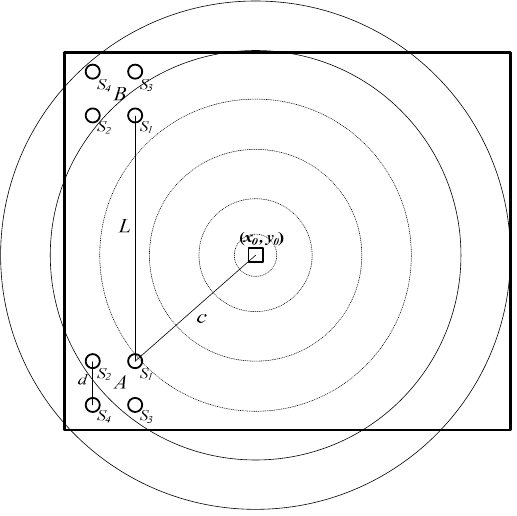
Figure 1. The fire source localization scene.